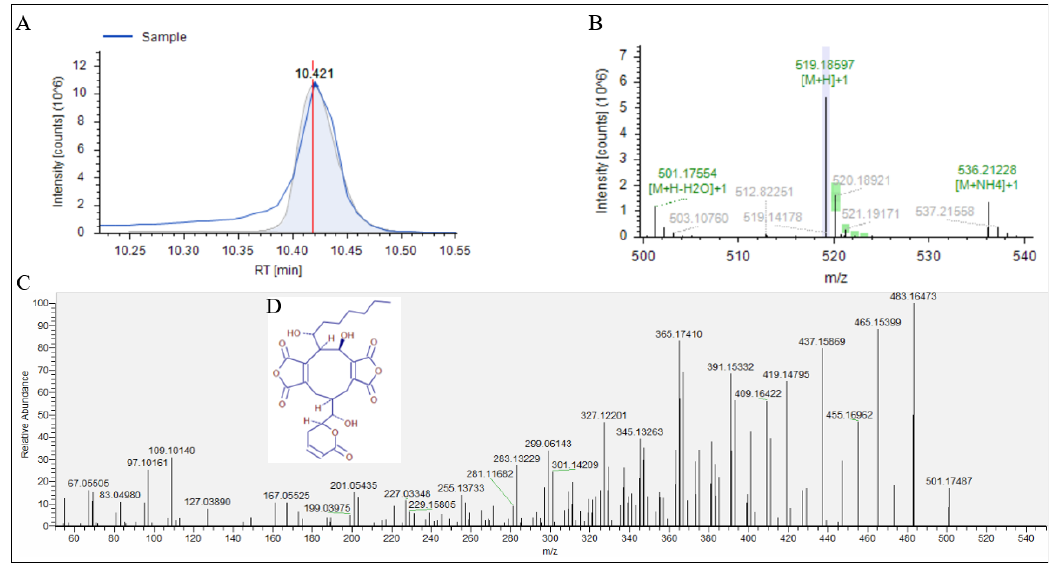
Figure 4. Analysis of No.2. ( A ) chromatogram of No.2. ( B ) parent ion and isotope. ( C ) The MS 2 spectrum of parent ion m / z 519.18597. ( D ) structure of rubratoxin B. Table 4. Chromatography and mass spectrometry information in the components of Fr.2.2.2.